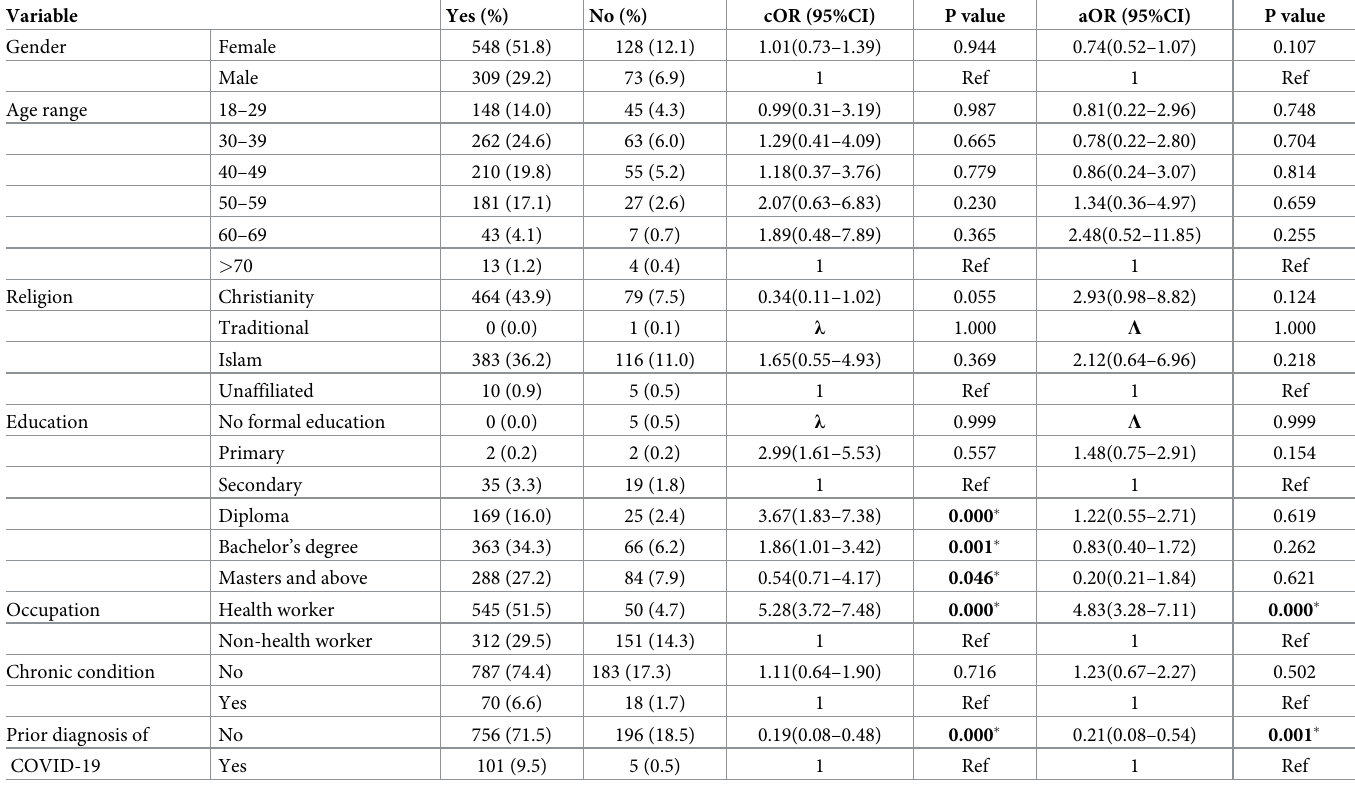
Table 5. Associated sociodemographic factors influencing the willingness to receive the COVID-19 vaccine.